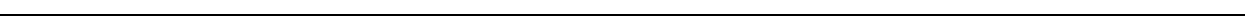
Fig. 4 Developmental Osr1 + cells are a source for adult FAPs. a Osr1 is expressed in PDGFR α + interstitial mesenchymal progenitors at birth (postnatal day P0). b Osr1 cell lineage tracing in adult (P84/12 week) Osr1 GCE/ + ; R26R LacZ/ + animals after Tamoxifen induction at P0. Osr1 + cell progeny is marked by immunolabelling for beta-Galactosidase (bGal). Perinatal Osr1 + cells give rise to interstitial PDGFR α + FAPs. c Osr1 cell lineage tracing in adult (12 week) Osr1 GCE/ + ; R26 mTmG/ + animals after Tamoxifen induction at P0; Osr1 + / + ; R26 mTmG/ + animals used as controls are shown left. FAPs (Sca1 + , CD34 + ), satellite cells (SAT) and double-negaitve cells (DN) were FACS-isolated and analysed for mGFP expression. Only FAPs contained a clearly detectable mGFP + population ( n = 3). d mGFP + and mGFP − FAPs isolated as in c were cytospun and analysed for PDGFR α and Tcf4 expression. Quanti fi cation is shown below ( n = 3). e The contribution of p0 Osr1 + cells to muscle interstitial PDGFR α + and Tcf4 + cells was quanti fi ed on sections of Osr1 GCE/ + ; R26 mTmG/ + animals in the indicated muscles. Quanti fi cation is shown below ( n = 4). Values represent mean ± s.e.m. N-numbers indicate biological replicates, i.e. samples from different